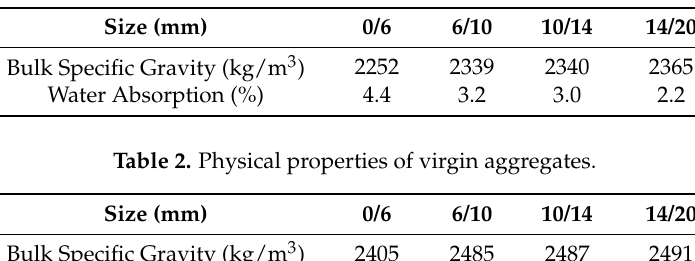
Table 1. Physical properties of reclaimed asphalt aggregates.